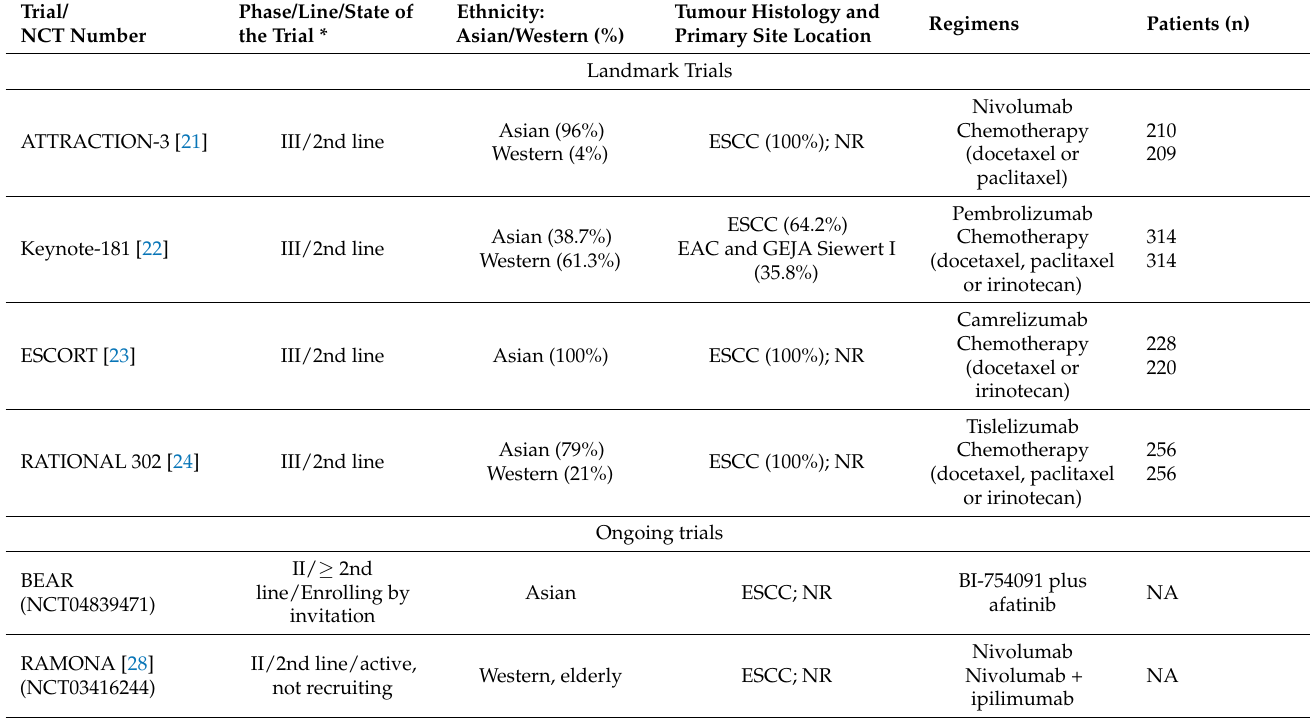
Table 2. Immune checkpoint inhibitors in the second and later lines setting for metastatic oesophageal squamous cell cancer: landmark phase III and main ongoing